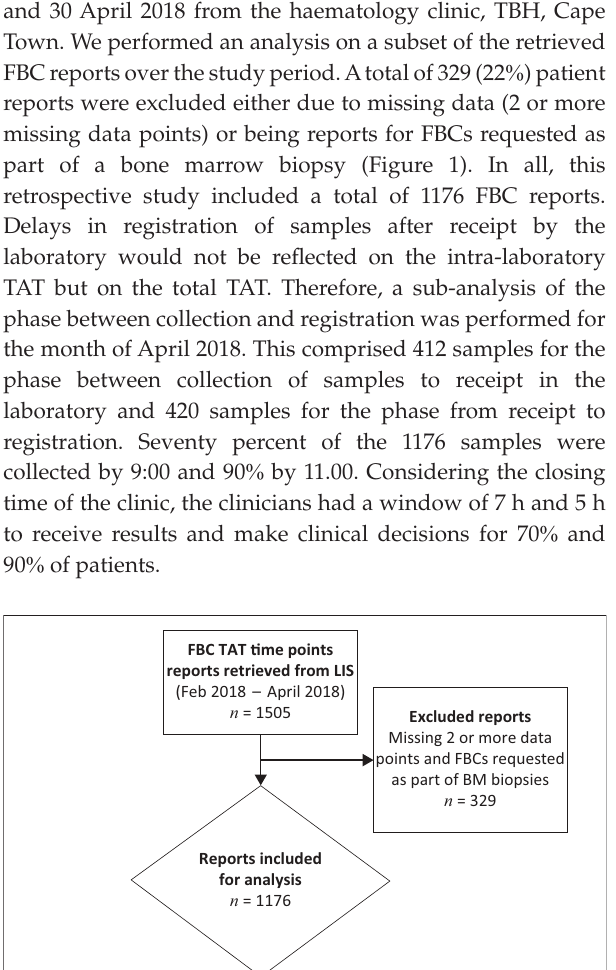
FIGURE 1: Screening and selection of reports of full blood counts requested from the haematology outpatient department at Tygerberg Academic Hospital in Cape Town, South Africa, over the period February 2018 to April 2018.